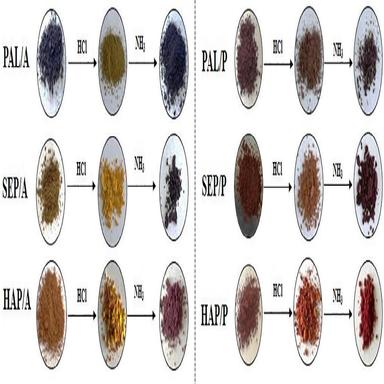
Digital images of the hybrid pigment powders exposed to acidic/basic vapors for 24 h.